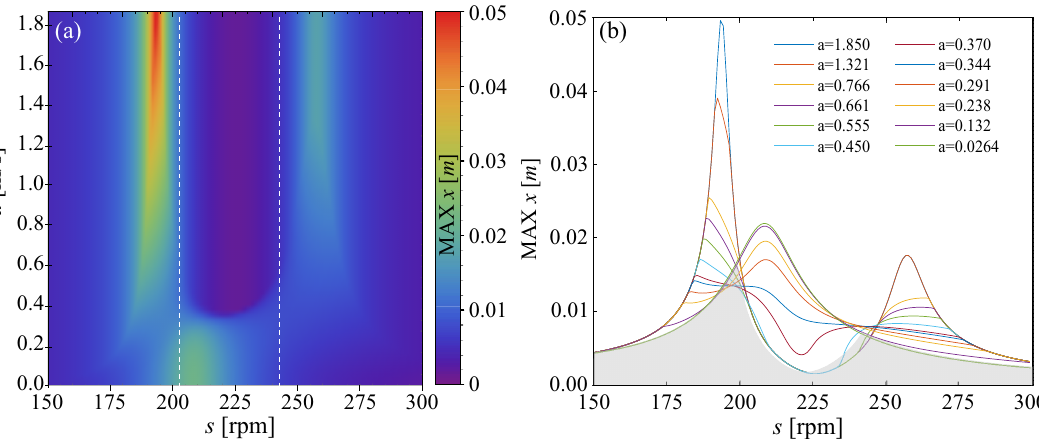
Figure 8. In panel ( a ), we show two dimensional plots of maximum amplitude of damped system (max x [ m ] ) in two parameters of space: a and s for damping function given by equation (Equation (8)). Panel ( b ) shows twelve exemplary FRCs of damped system.